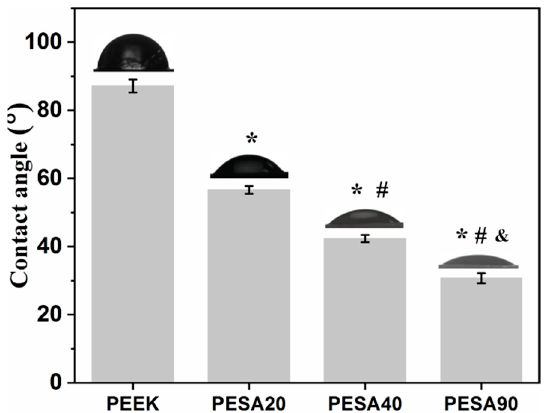
Figure 3. Water contact angles of PEEK, PESA20, PESA40, and PESA90. Statistically significant differences were indicated by * p < 0.05 compared with the PEEK, # p < 0.05 compared with the PESA20 and & p < 0.05 compared with the PESA40. All data represent the mean value ± standard deviation ( n = 4 per group).